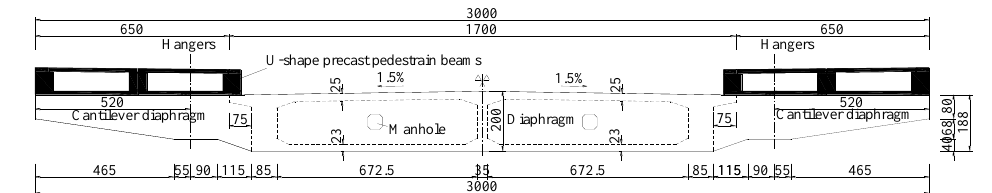
Figure 2. Cross-section of the box concrete stiffening girder (unit: cm).